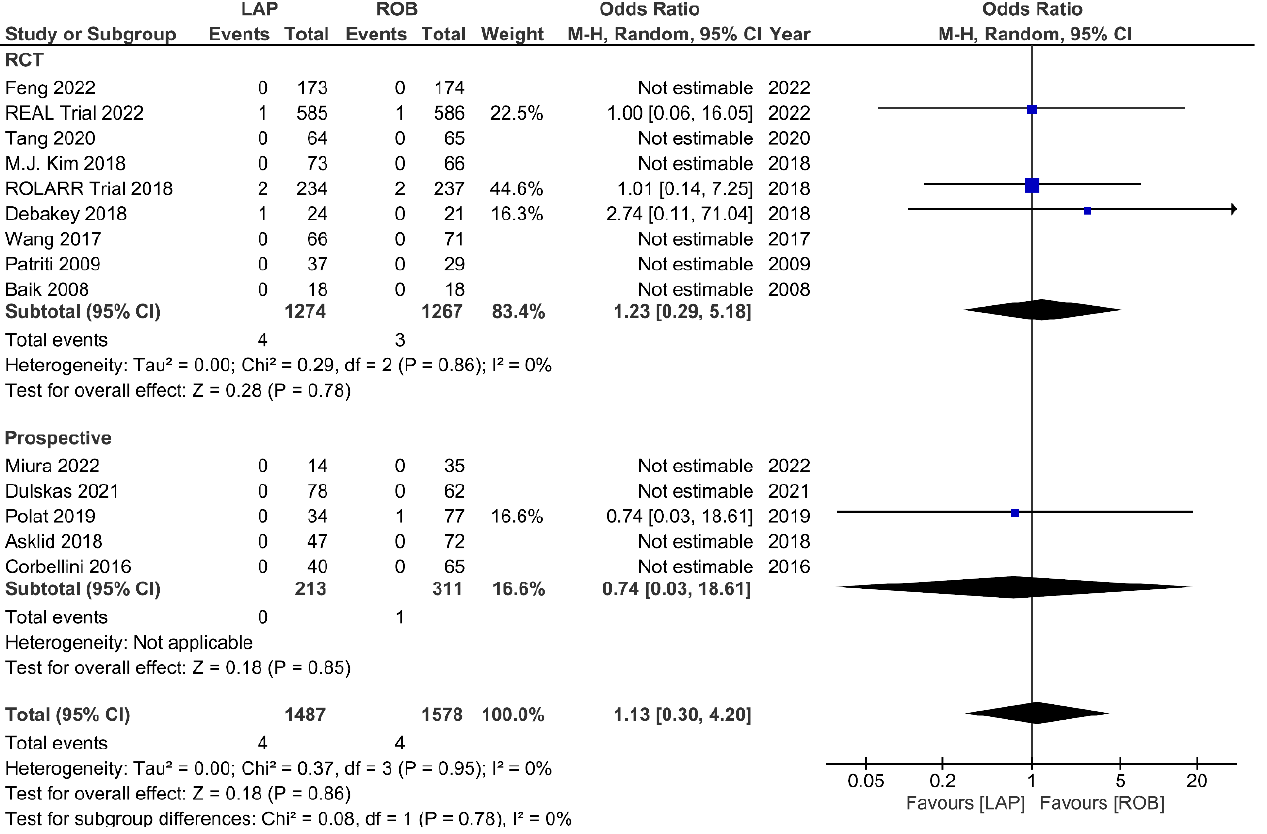
Figure 13. Forest plots comparing up to 90-day mortality [6,17 – 19,23,34,35,37,39,41,42,45,47,51,52] between robotic and laparoscopic rectal resection (blue boxes representing odd ratios, arrows representing 95% confidence intervals, and diamonds representing point estimates of pooled odd ratios or mean differences).